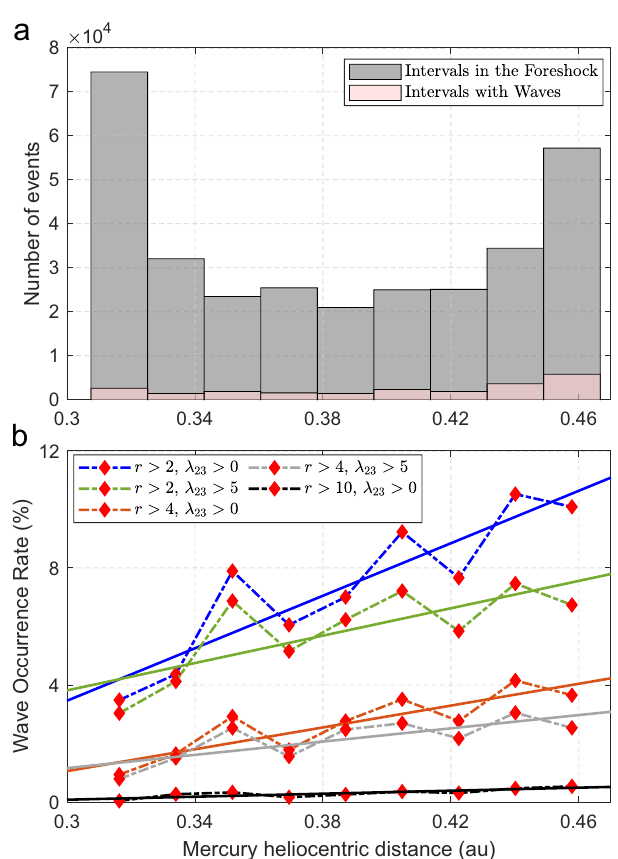
Fig. 3 Wave Occurrence rate as a function of Mercury ’ s heliocentric distance. a Histograms of the number of selected intervals in the selected region inside the Hermean foreshock (gray) and with wave detection (pink) as a function of Mercury ’ s heliocentric distance when r = 2, λ 23 = 0; b Wave occurrence rate as a function of Mercury ’ s heliocentric distance for fi ve different selection criteria (dash curves) and their respective linear fi ts (solid line with the same corresponding color). r is a factor associated with the intensity of magnetic fi eld power spectral density at the wave frequency range of interest, and λ 23 constitutes a threshold for the intermediate to minimum eigenvalue ratio associated with Minimum Variance Analysis. The reader is referred to Eqs. (1) – (3) for a strict de fi nition.